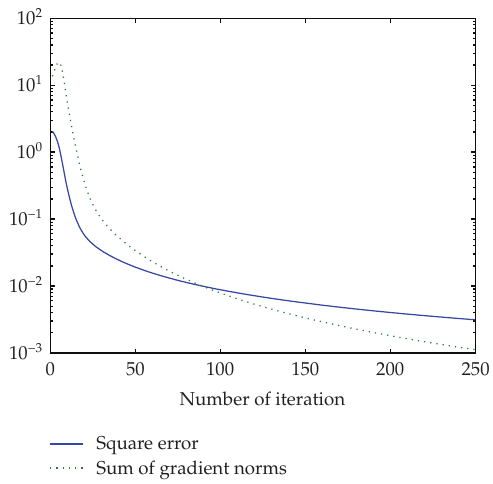
Figure 2: Convergence behavior of BSCBP algorithm for solving XOR problem. (cid:2) sum of gradient norms (cid:7) (cid:4) M (cid:2) (cid:8) Δ w n,R (cid:8) 2 (cid:8) (cid:8) Δ w n.I m m (cid:7) 1